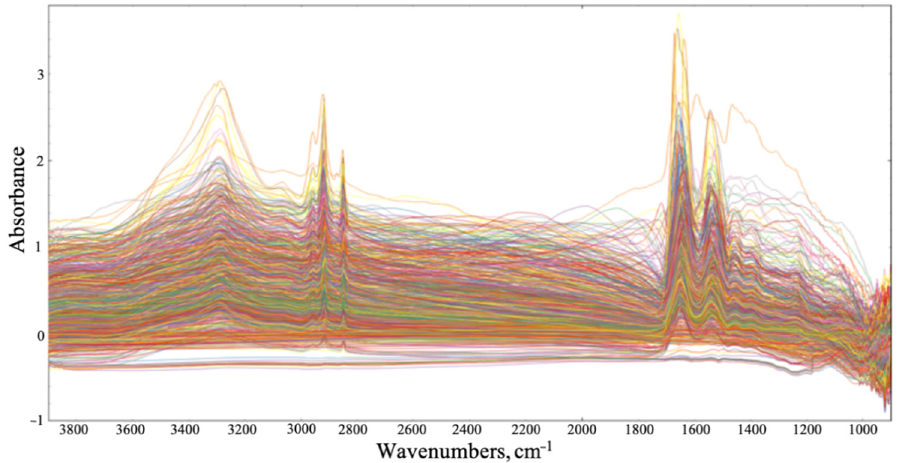
Figure 3. 1000 randomly selected raw spectra from the synchrotron dataset displaying highly variable baselines and scattering effects.